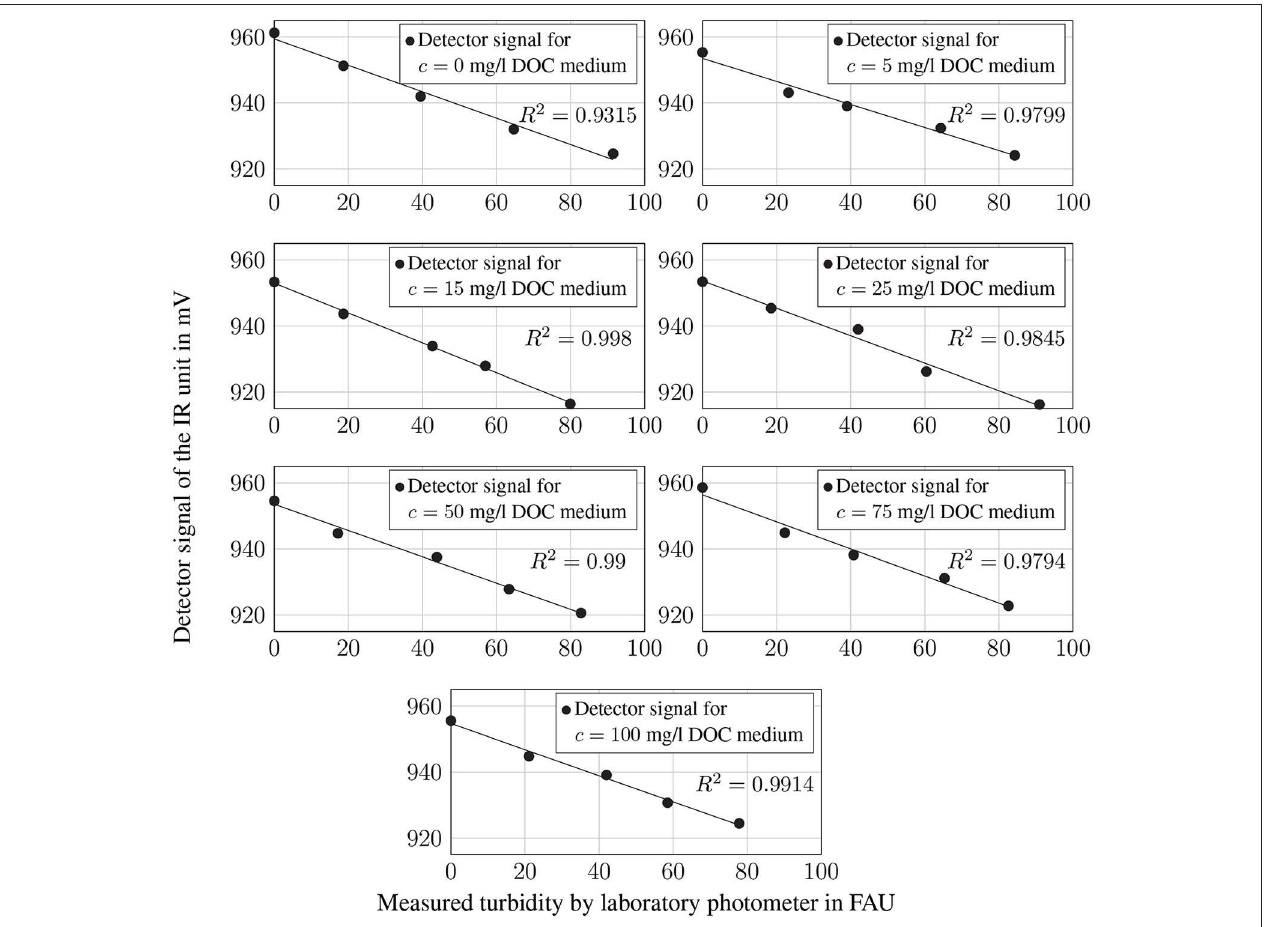
FIGURE 5 | Measured detector signal of the IR sensor in mV for all DOC concentrations and different turbidity values in comparison with the turbidity values measured using a laboratory photometer. The trend line was generated by linear regression.